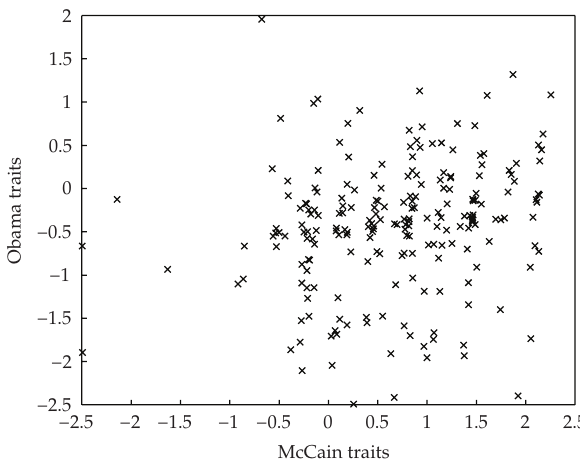
Figure 8: Scatterplot of Obama and McCain traits for McCain